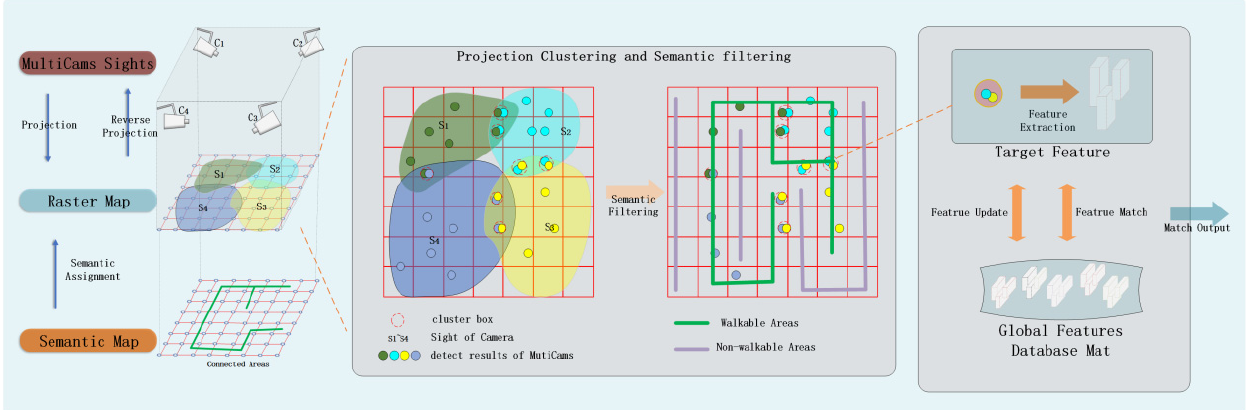
Figure 6. Co-visibility semantic information and coarse matching.